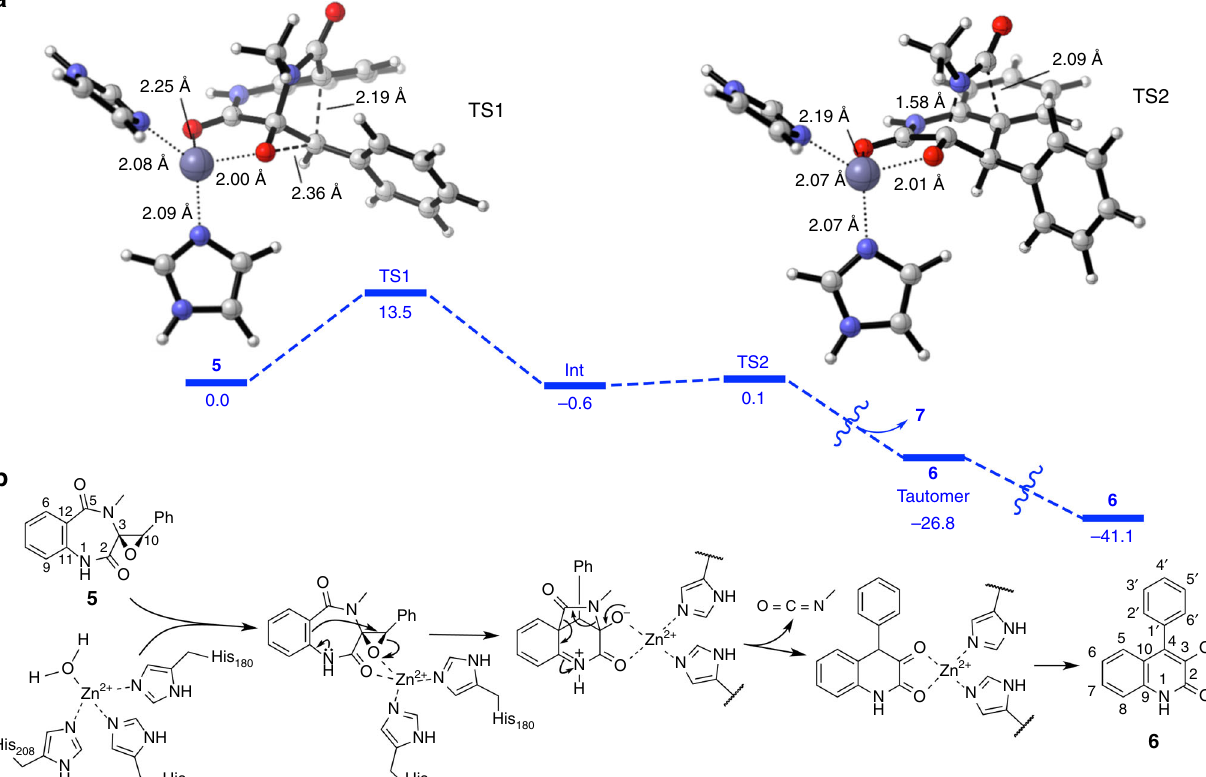
Fig. 4 Computational analyses of the AsqI-catalyzed ring contraction reaction. a The metal-binding site of AsqI. Computational results on the full reaction pathway for the transformation of 5 into 6 , catalyzed by a Zn 2 + ion tetracoordinated to the substrate and two molecules of imidazole as a model for a histidine side chain. Calculated free energy differences ( Δ G ) in kcal mol – 1 are given below the bold bars. The largest barrier is the fi rst transition state (TS1) involving the opening of the cyclopenin epoxide and formation of the methylamide-bridged intermediate (Int). The second transition state (TS2) leading to the elimination of 7 and formation of the 6,6-bicyclic core is virtually barrierless. Computed TS1 and TS2 structures are shown. Carbon, oxygen, nitrogen and zinc atoms in the ball-and-stick models are in white, red, darker blue, and lighter blue, respectively. Breaking and forming bonds are shown as thick broken lines, while bonds between the zinc atom and other bound atoms are shown as thin dotted lines. b The proposed mechanism for the conversion of 5 to 6 catalyzed by the AsqI – Zn 2 + complex. The Zn 2 + ion bound to His176 and His180 is thought to catalyze the reaction as a Lewis